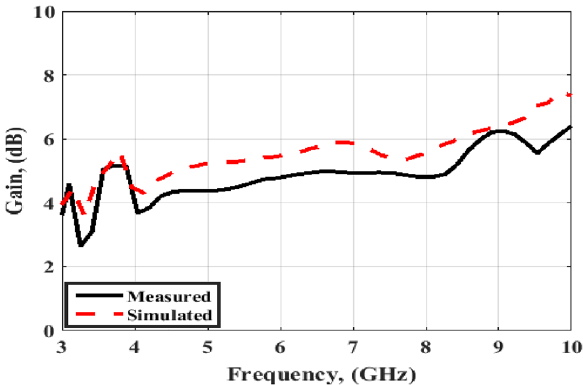
Figure 12. Port #1 peak gain simulated and testing outcomes of the flexible MIMO antenna in a flat configuration.